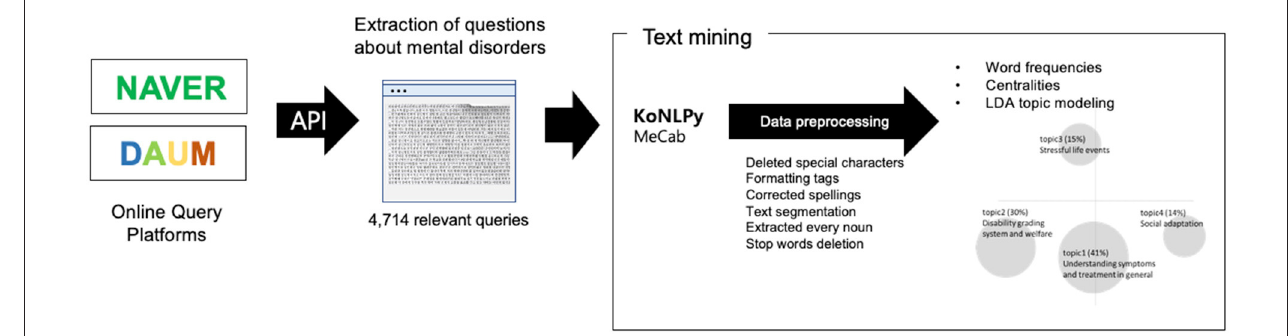
FIGURE 2 | Study procedure.